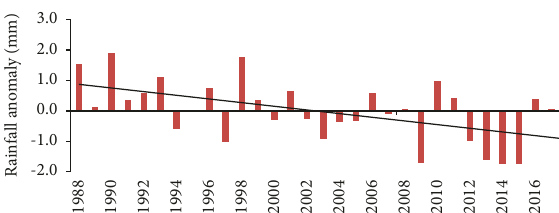
Figure 3: Annual rainfall anomaly at Welmera district in the period of